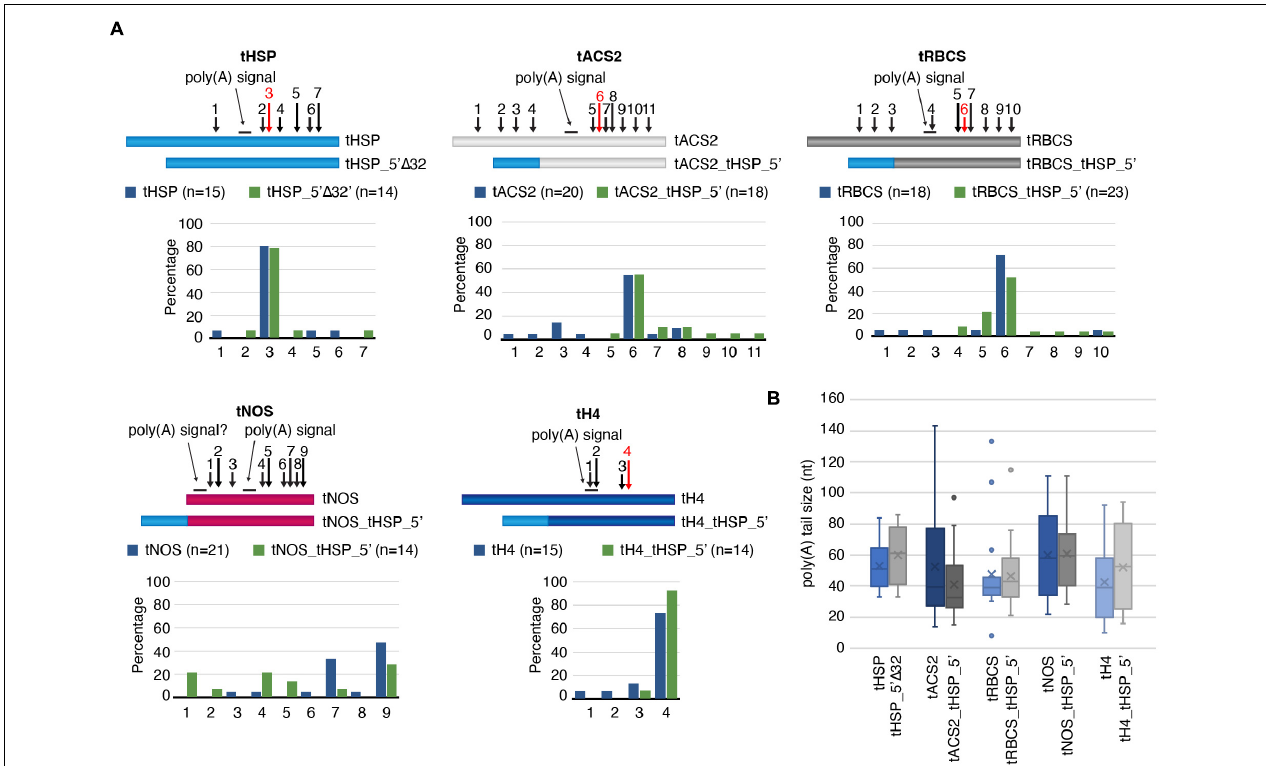
FIGURE 6 | Analysis of the poly(A) tail formation. (A) Mapping of the poly(A) sites in wild-type and mutant terminators. For each regulatory sequence, a graphic representation of the different terminators with the identified cleavage positions (numbered arrows) and the percentage of these sites are given. The dominant poly(A) sites (as expected from previous publications) are indicated by red arrows. The poly(A) signals are shown as a line above the illustration. (B) The poly(A) tail average size with standard error is presented. The number of clones analyzed is the same as indicated in panel A, except for tHSP (14 clones), tHSP_5 (cid:48) (cid:49) 32 (13 clones) and tRBCS (17 clones). All data originated from a single